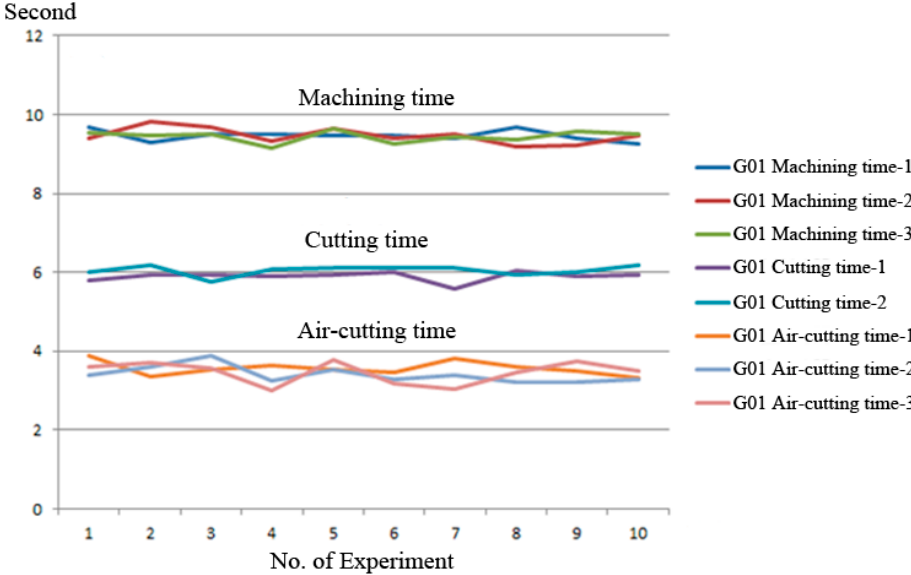
Figure 5. Monitoring result of G00 air cutting time.